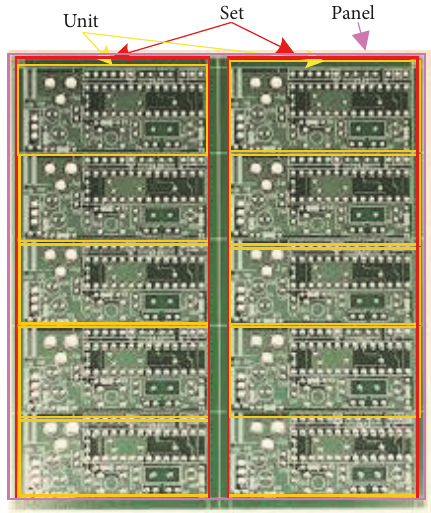
Figure 1: Structure of a PCB